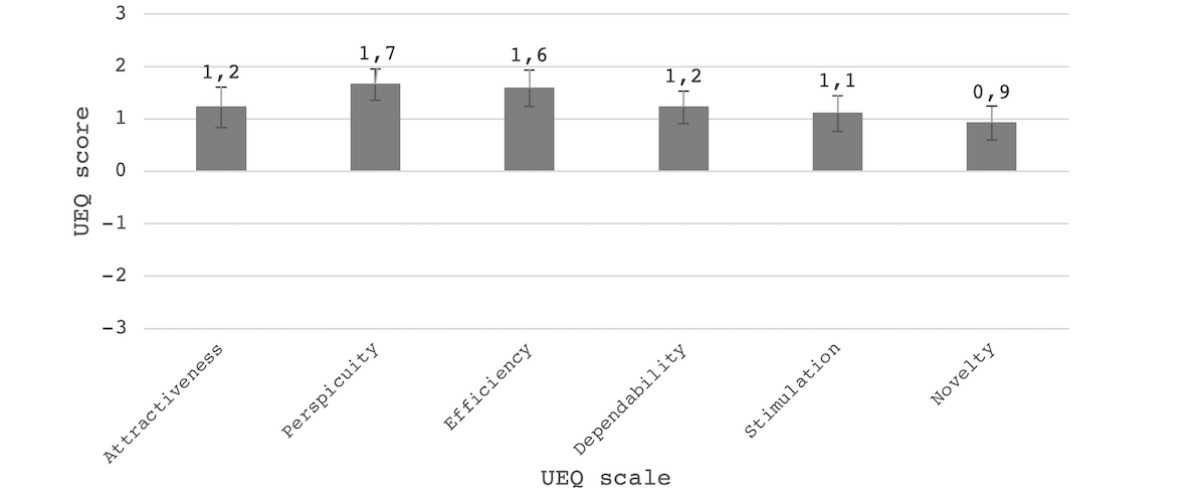
Figure 2. Boxplot with a mean score per User Experience Questionnaire (UEQ) scale for the total population, scoring from –3 (horribly bad) to +3 (extremely good). The error bars show confidence